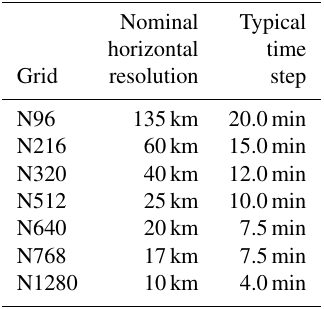
Table 1. Typical time step for a range of horizontal